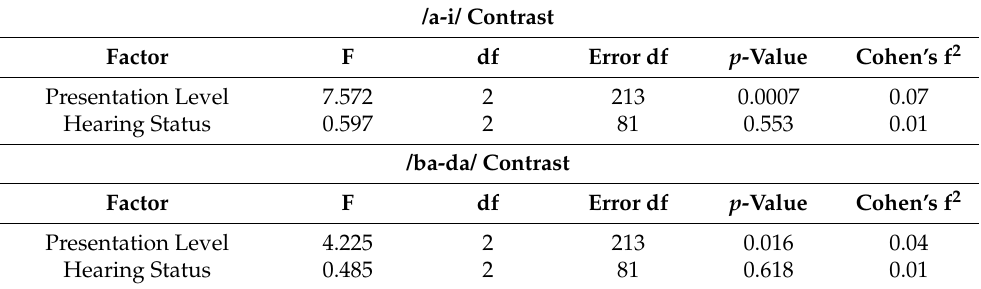
Table 4. Results of multivariate ANOVA predicting sensitivity to /a-i/ and /ba-da/ contrasts.